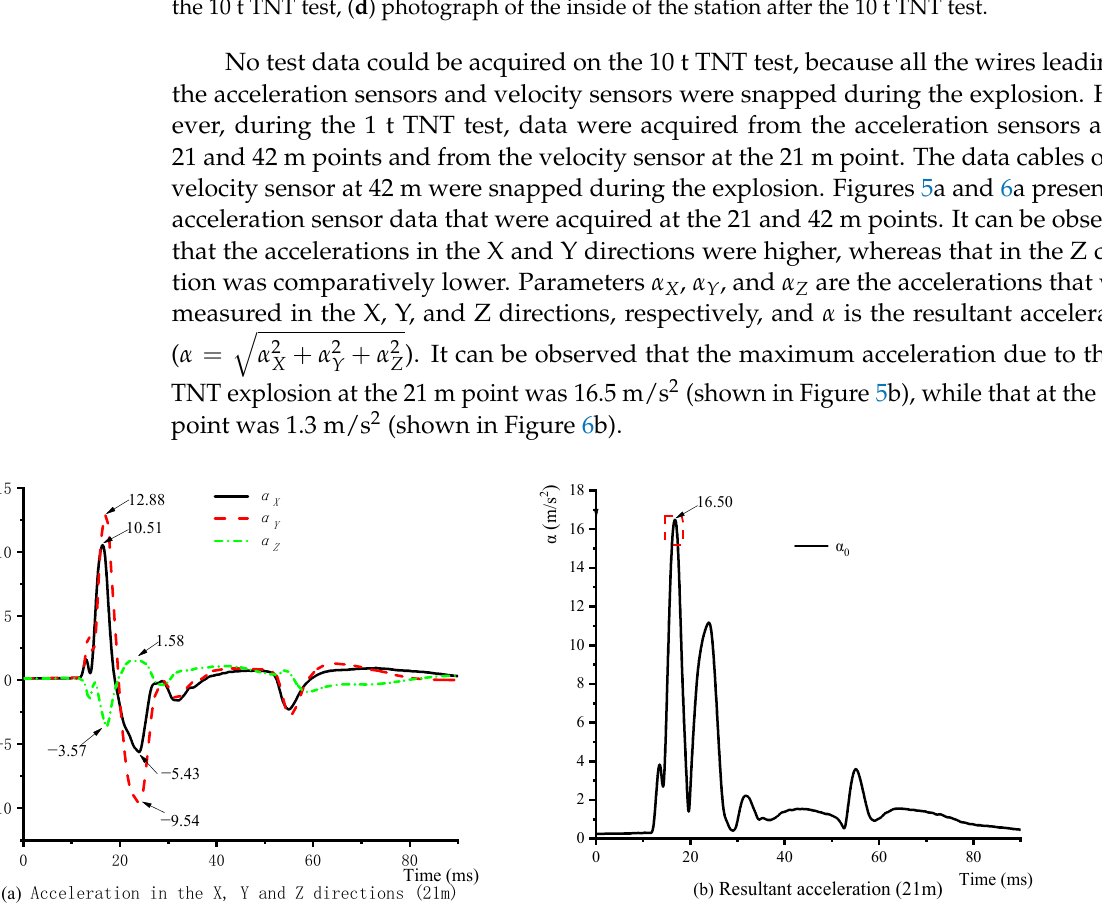
Figure 5. Acceleration data measured at 21 m in the one-ton TNT ground explosion test.